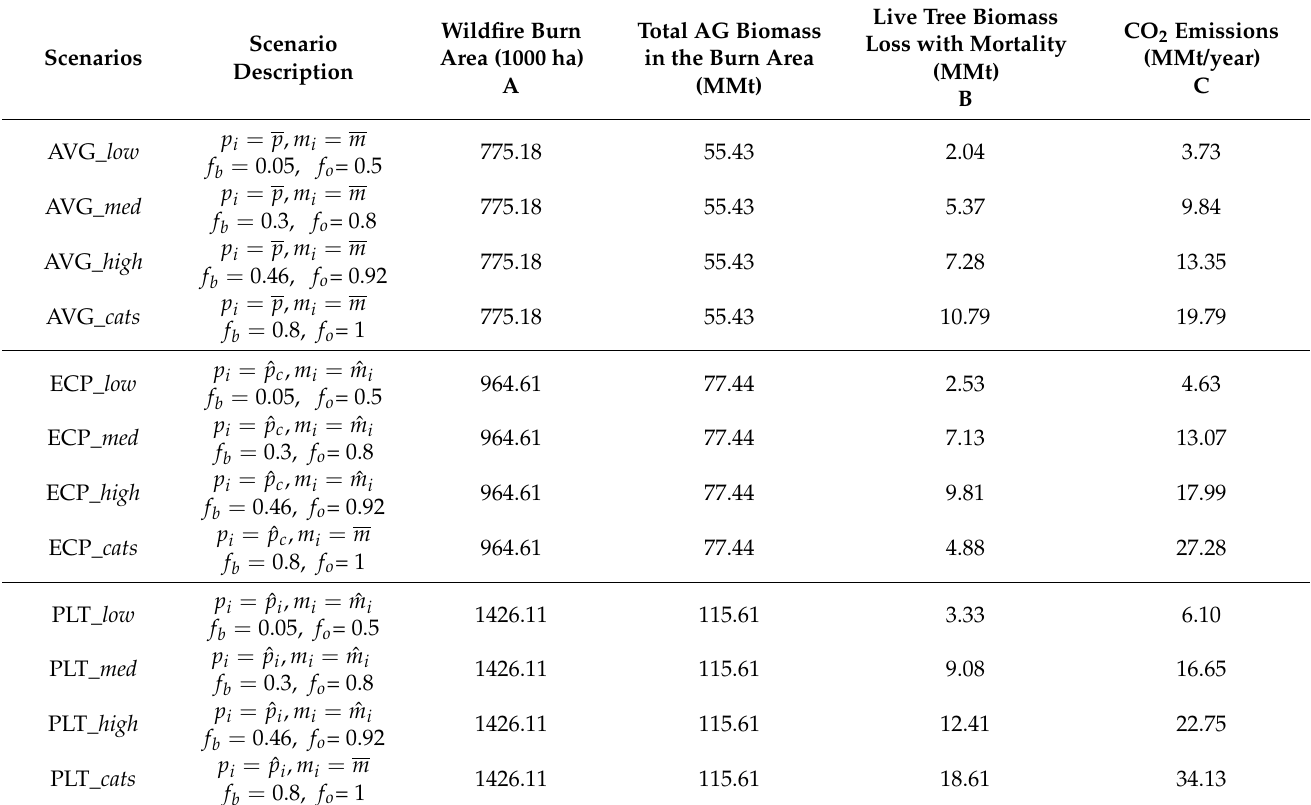
Table 5. Annual estimates of forest area burned, live biomass lost, and the CO 2 emissions under different combustion rates and various scenarios due to wildfires in the continental United